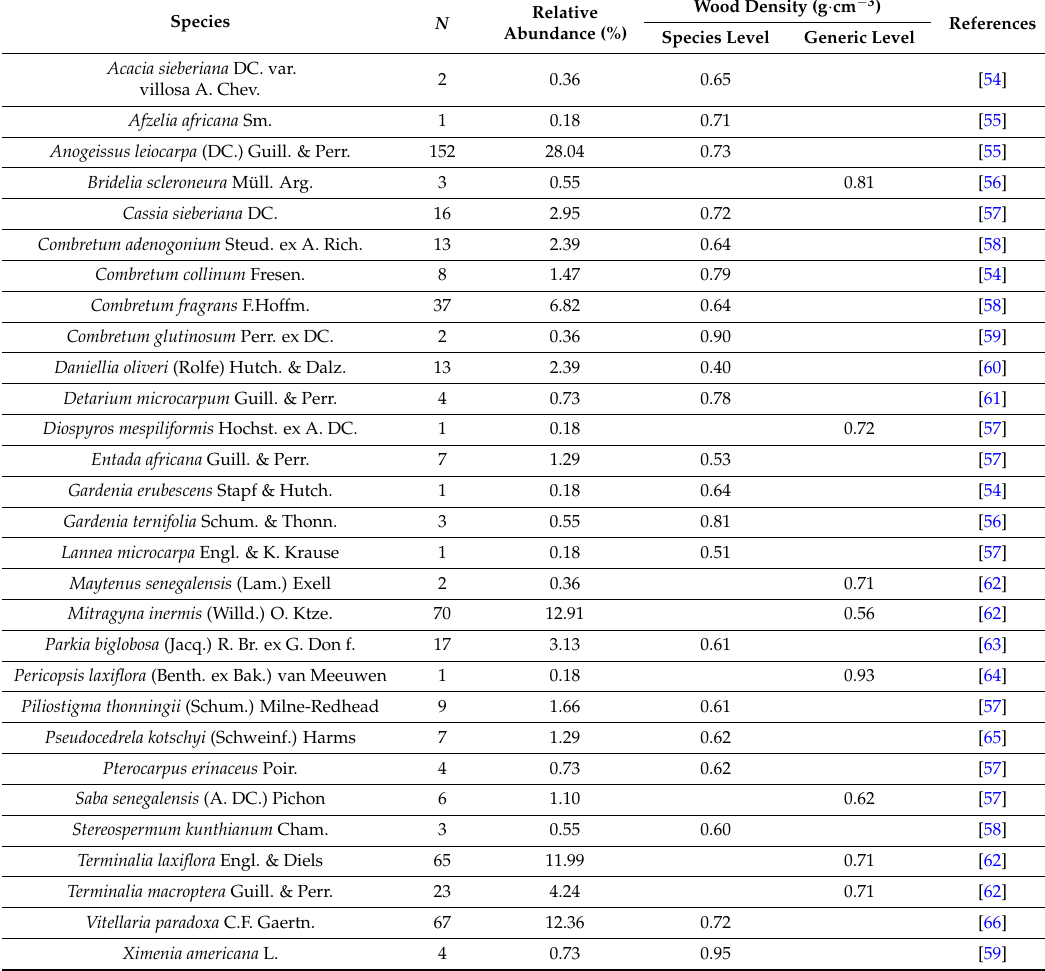
Table A1. Species represents the tree species at both sites of Nazinga Game Ranch and Bontioli Nature Reserve collectively. N = number of trees for each species. Relative abundance (%) (percentage of tree species individuals relative to the total number of trees). Wood density represents the published values of wood densities at species and generic levels for all the trees at both